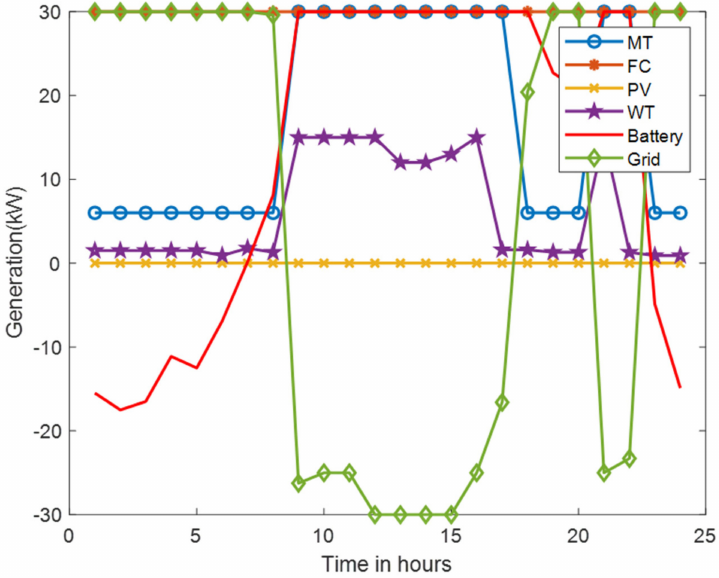
Figure 11. Power generation for Scenario